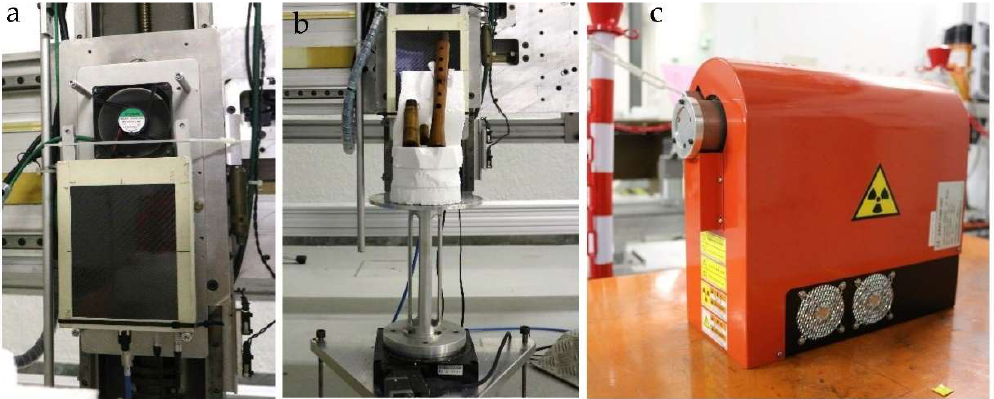
Figure 3. Experimental setup: ( a ) Flat-panel detector, ( b ) sample on the rotating platform, ( c ) X-ray